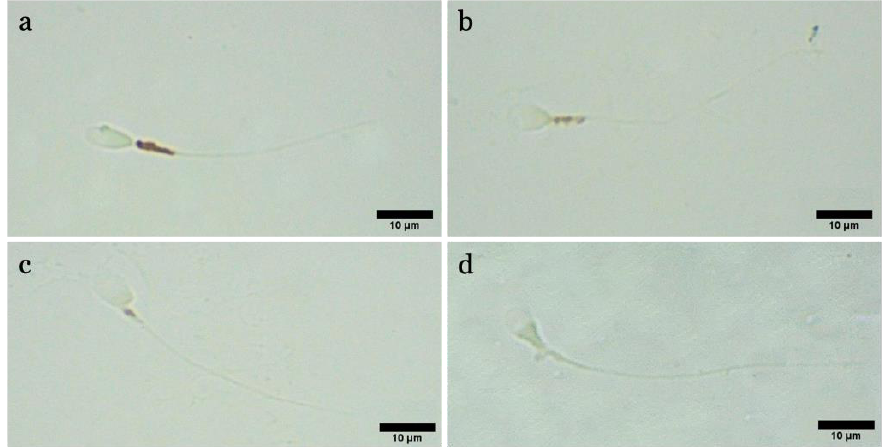
Figure 11. Observation of a casual field of spermatozoa subjected to DAB test to assess mitochondrial activity (DAB): ( a ) spermatozoon of class I with 100% of intermediate segment colored; ( b ) spermatozoon of class II with >50% of intermediate segment colored; ( c ) spermatozoon of class III with <50% of intermediate segment colored; ( d ) spermatozoon of class IV with no colored intermediate segment.